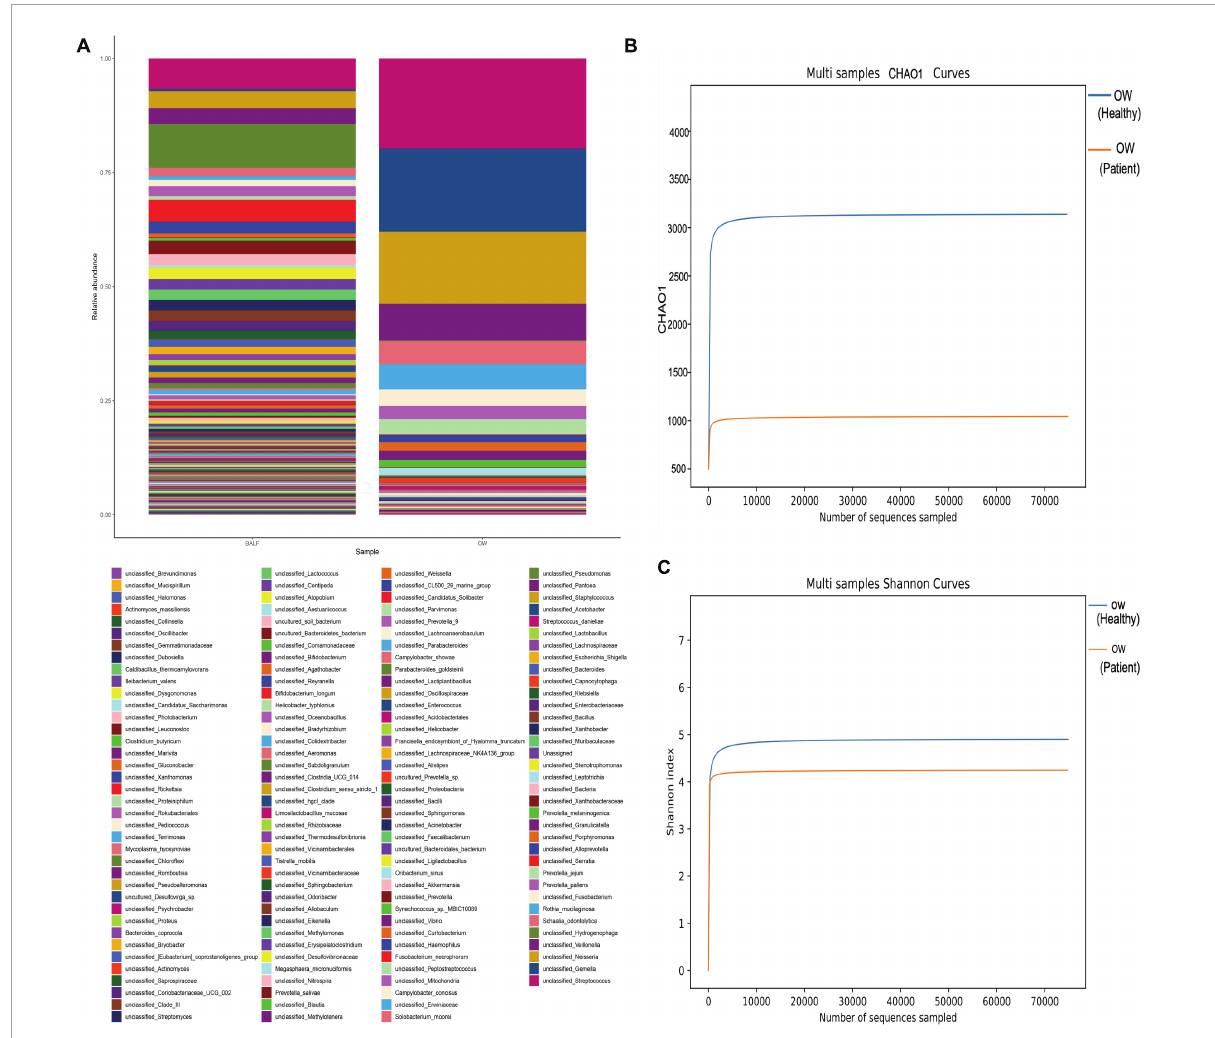
FIGURE3 Comparison of the oral and lung microbiome (heatmap). (A) No significant differences were found in P. micra between oral wash and BALF samples (0.11% in BALF vs . 0.13% in oral wash). (B,C) The α diversity of the oral microbiome comparing the patient to a healthy man. Both the Chao1 and Shannon indexes were lower in the patient (Chao1: 986 vs . 3,079, Shannon index: 4.244 vs .